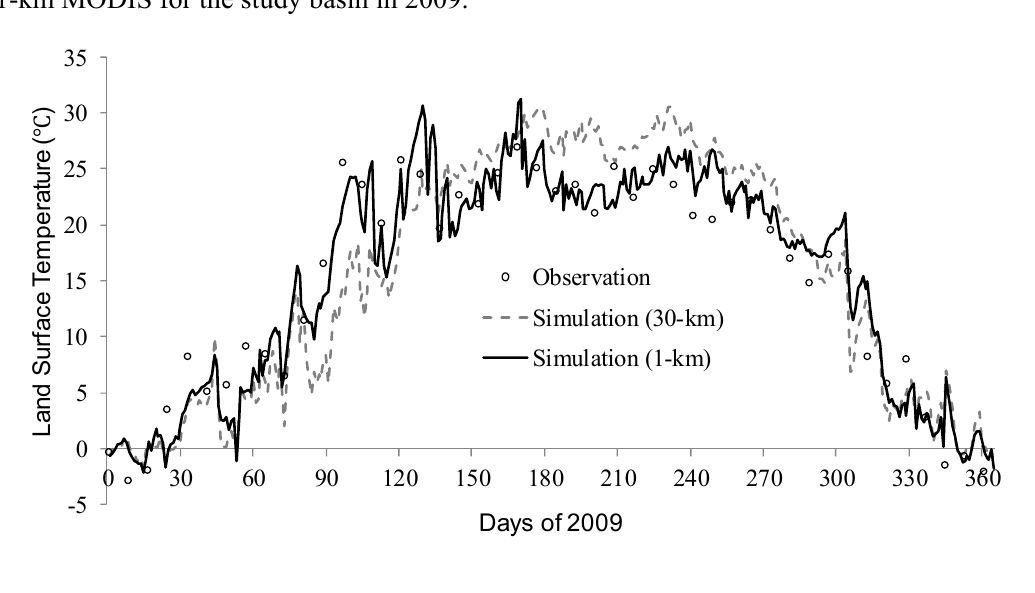
Figure 6. Comparison of daily time series of land surface temperatures simulated from the CoLM at 1-km and 30-km resolutions along with 8-day MODIS observations from the 1-km MODIS for the study basin in